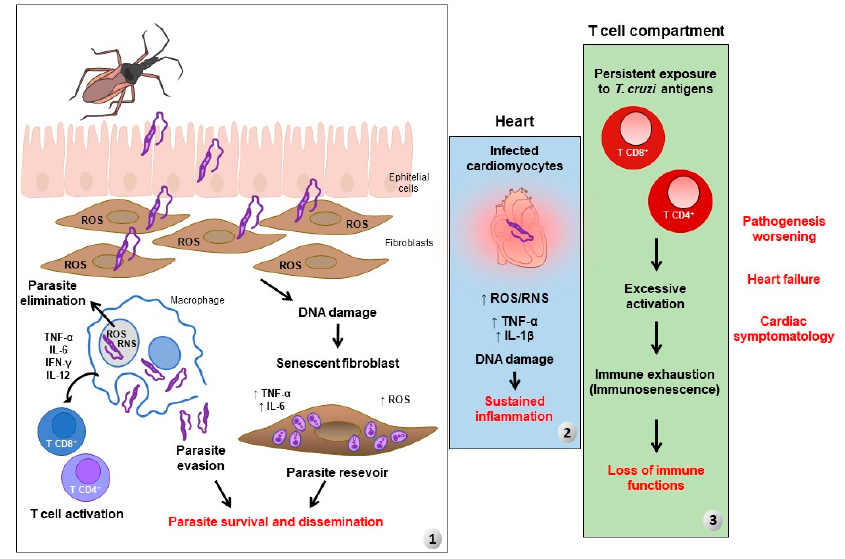
Figure A1. Trypanosoma cruzi -derived oxidative stress responses in cellular senescence induction. ( Panel 1 ) Trypanosoma cruzi infective metacyclic trypomastigotes are released along with the feces of the triatomine insect vector during its blood meal; and they can infect cells in the skin and der-